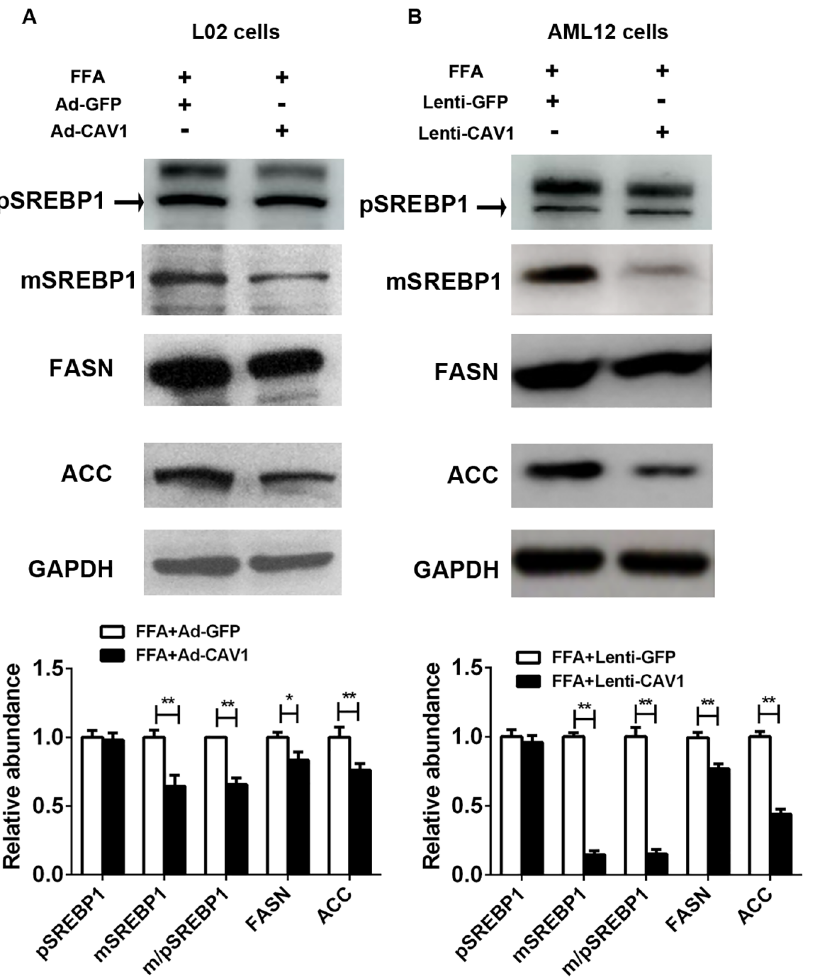
Fig 6. CAV1-overexpression downregulatesthe proteinexpression levelsof lipid metabolism genesin FFA-stimulatedL02cellsandAML12cells. L02cellsweretransfectedwithadenovirusrecombinationplasmids containingfull-lengthhumanCAV1DNAtooverexpress CAV1(Ad-CAV1), whileAML12hepatocyteswere transfectedwitha lentivirus-constructedsystemcontainingmousefull-lengthCAV1DNAto stablyoverexpress CAV1(Lenti-CAV1).Cellswerechallengedwith1 mMFFA for 48h.Theproteinexpressionlevelsoffatty acid metabolismgenes,includingSREBP1,FASNandACC,weredeterminedbywestern blotandquantifiedwith GAPDHasaloadingcontrolinL02cells(A) andAML12cells(B). pSREBP1 andmSREBP1denotetheprecursor andmatureformsofSREBP1, respectively.Theresultsrepresentdatafrom3independent experiments.